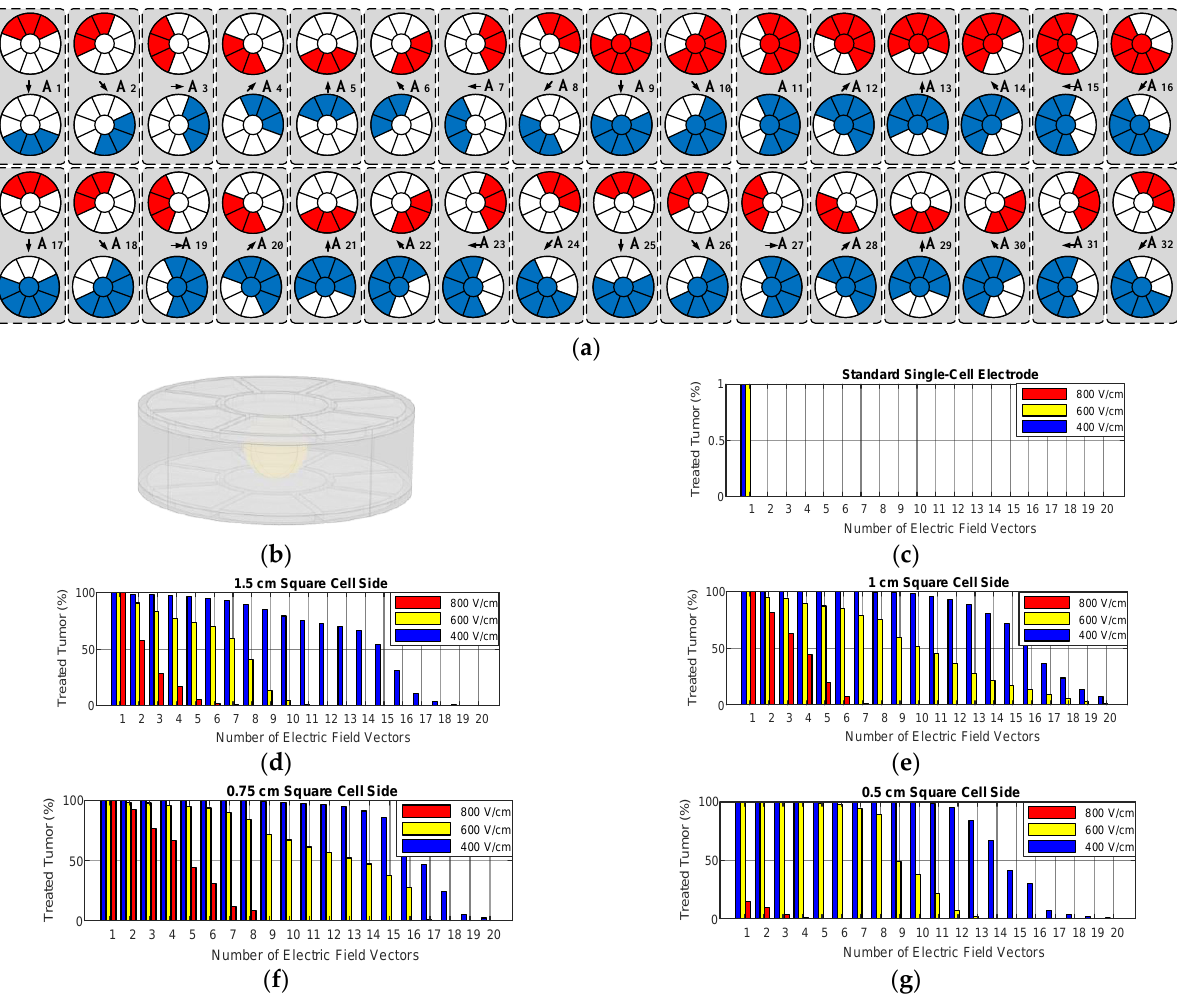
Figure 12. Circular electrode optimization results: ( a ) 32 CSs applied, and ( b ) geometry of the circular MPPE with tumor. Bar graphs with the percentage of tumor treated: standard electrode ( c ), 1.5 cm square electrode cell side ( d ), 1 cm square electrode cell side ( e ), 0.75 cm square electrode cell side ( f ) and 0.5 cm square electrode cell side ( g ).